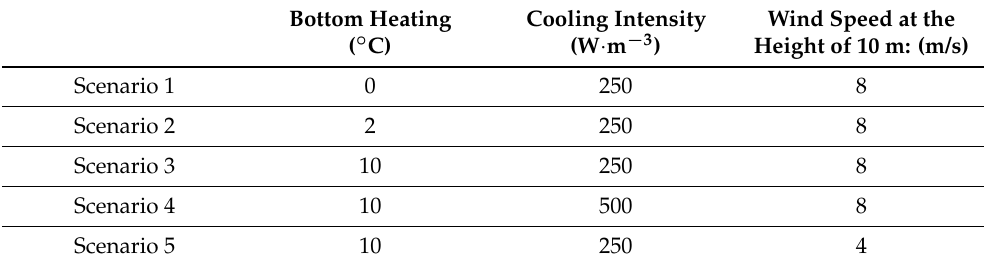
Table 3. Different scenarios for Test Case